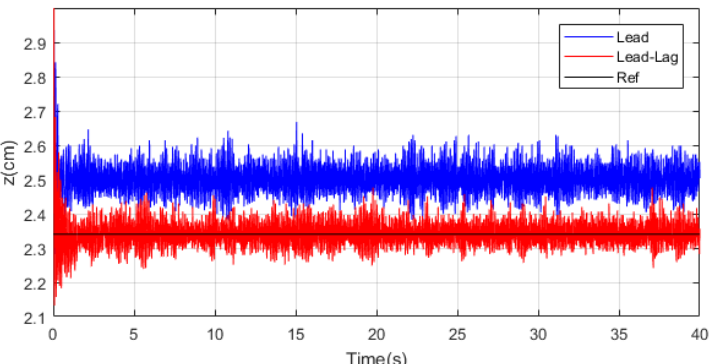
Figure 10. Real system responses with both classical controllers.